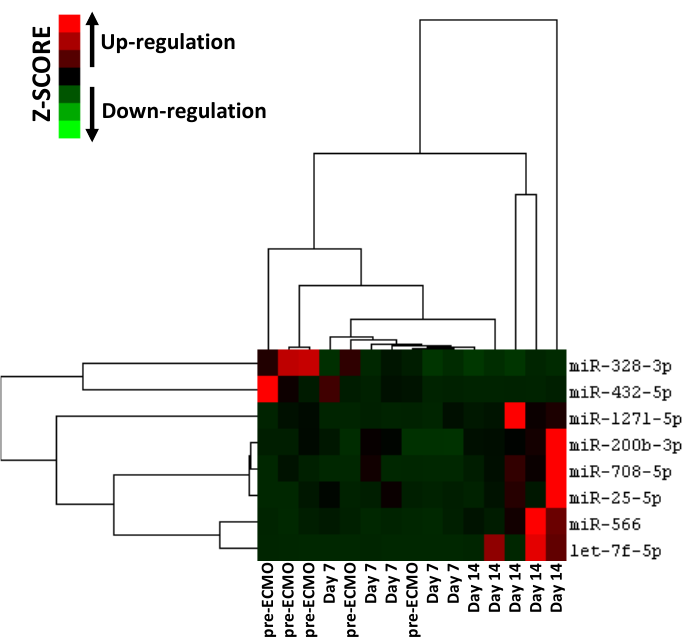
Figure 6. Hierarchical clustering analysis based on eight selected miRNA expression levels in ARDS patients supported with ECMO for 14 days. Heatmap colors represent relative miRNA expression normalized to housekeeping.